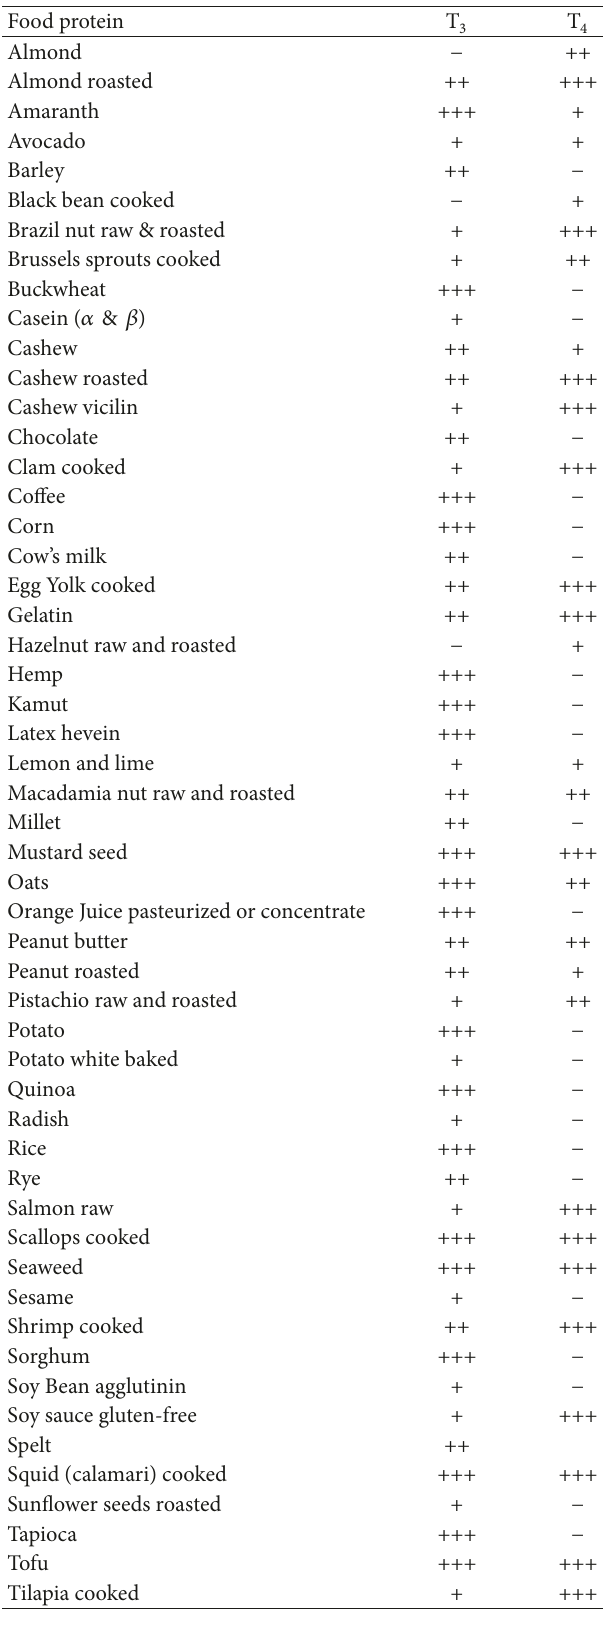
Table 2: Continued. Food protein T 3 T